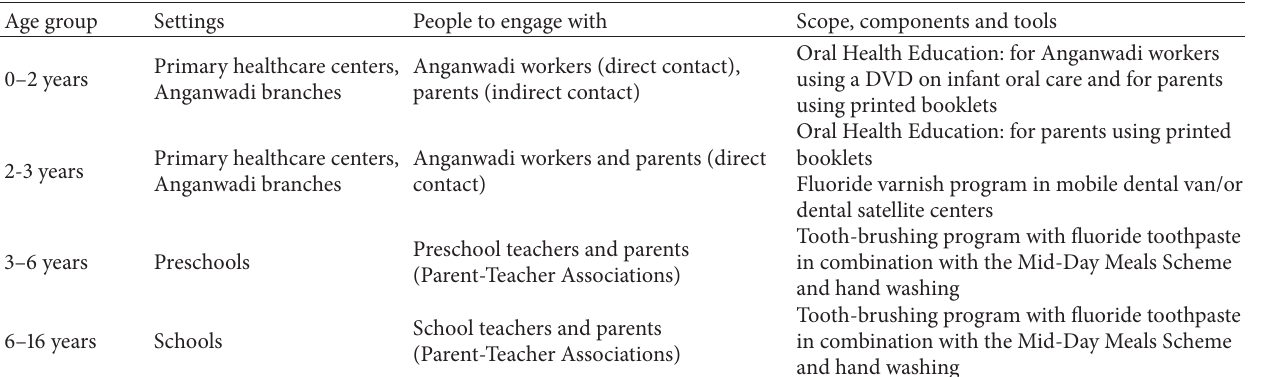
Table 1: Model for infant and child oral health promotion agewise